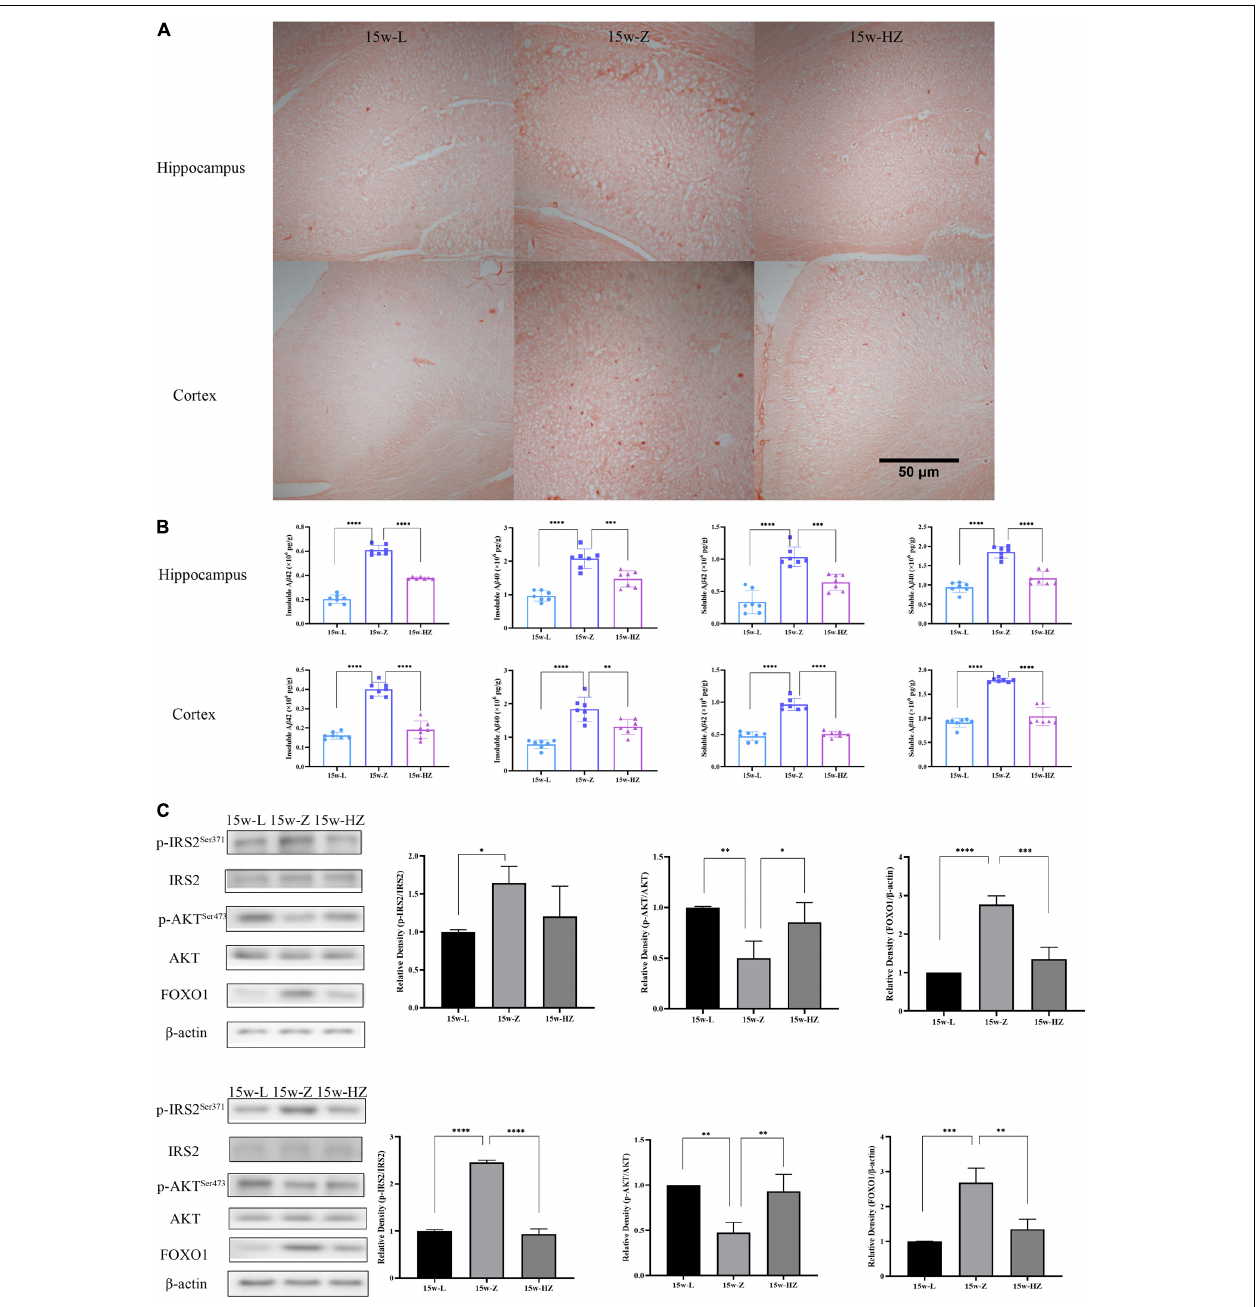
FIGURE 5 | Effect of ZBPYR on A β deposition and insulin signaling pathway protein expression in the brain. (A) Congo red staining (40 × ). (B) A β content in hippocampus and cortex. (C) Protein expression of insulin signaling pathway in hippocampus and cortex. Data are shown as mean ± SD. n = 7 per group. * p < 0.05, ** p < 0.01, *** p < 0.001, **** p <